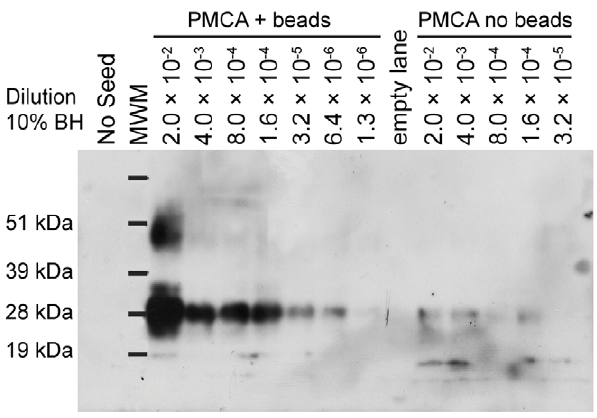
Figure 1. Teflon H beads in PMCA reaction increase sensitivity and yield of PrP CWD . CWD-positive brain homogenate (BH; 10% w/v) was serially diluted in normal BH (NBH). A 10 m L aliquot of the seed dilution was transferred into 90 m L NBH with 0.05% saponin in five-fold increments and subjected to PMCA (96 cycles) in the presence or absence of two 2.32 mm Teflon H beads (PMCAb). The no-seed control was 100 m L NBH treated as the other samples. MWM, molecular weight